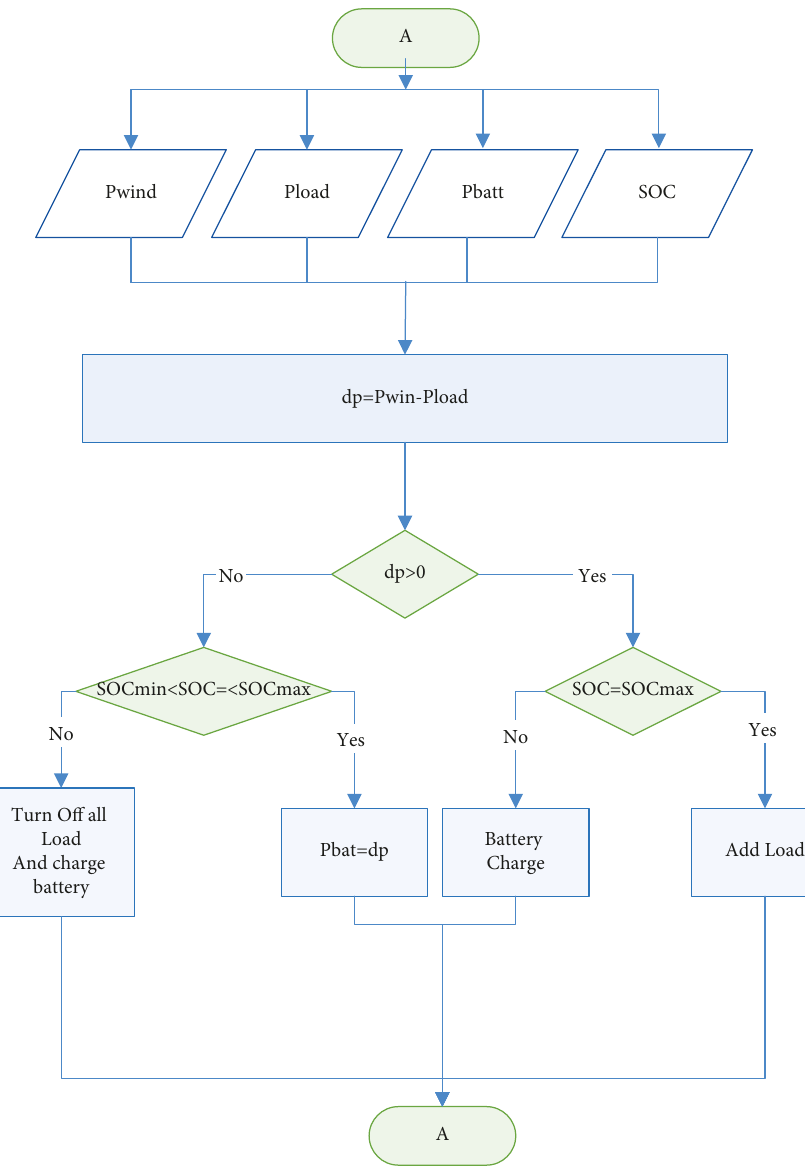
Figure 7: Power management flow chart.